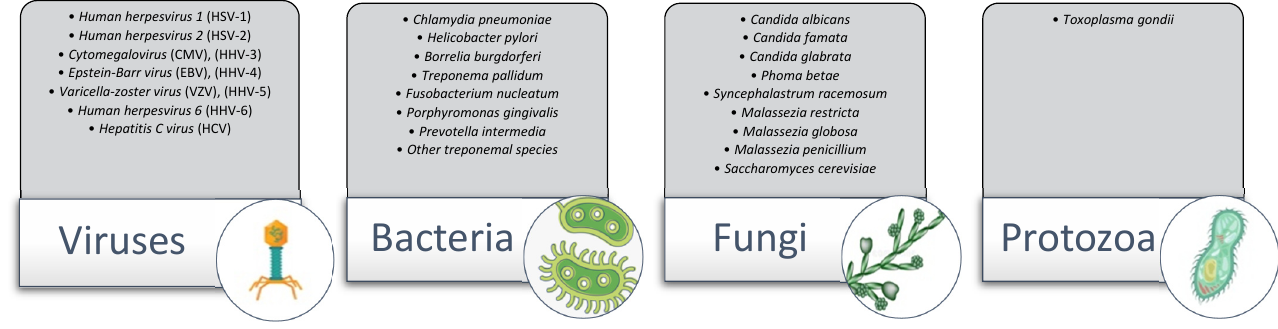
Figure 3. Pathogens associated with the development of AD.